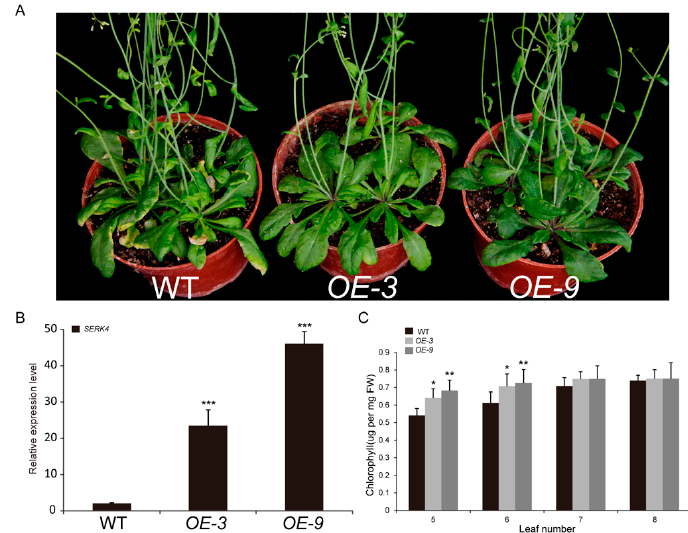
Figure 5. The delayed senescence phenotype of the SERK4 overexpression lines; ( A ) the leaf senescence phenotype of the six-week-old wildtype and two SERK4 overexpression lines plants; ( B ) the expression level of SERK4 gene in wildtype and two SERK4 overexpression lines, the ratios of SERK4 gene expression level were calculated relative to the wildtype; ( C ) the chlorophyll contents of the wildtype and two SERK4 overexpression lines. WT, wildtype; OE, overexpression line. In B and C, the data are means ± SD of three biological repeats. * p < 0.05, ** p < 0.01, *** p < 0.001 ( t -tests).